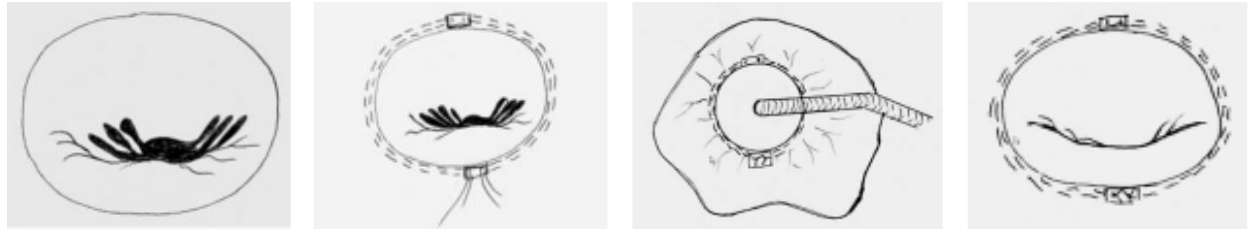
Fig. 2 - Aspectos gráficos da técnica de anuloplastia. (A) – Valva mitral insuficiente / (B) – Sutura contínua dupla no anel mitral / (C) – Medida do diâmetro desejado / (D) – Aspecto final